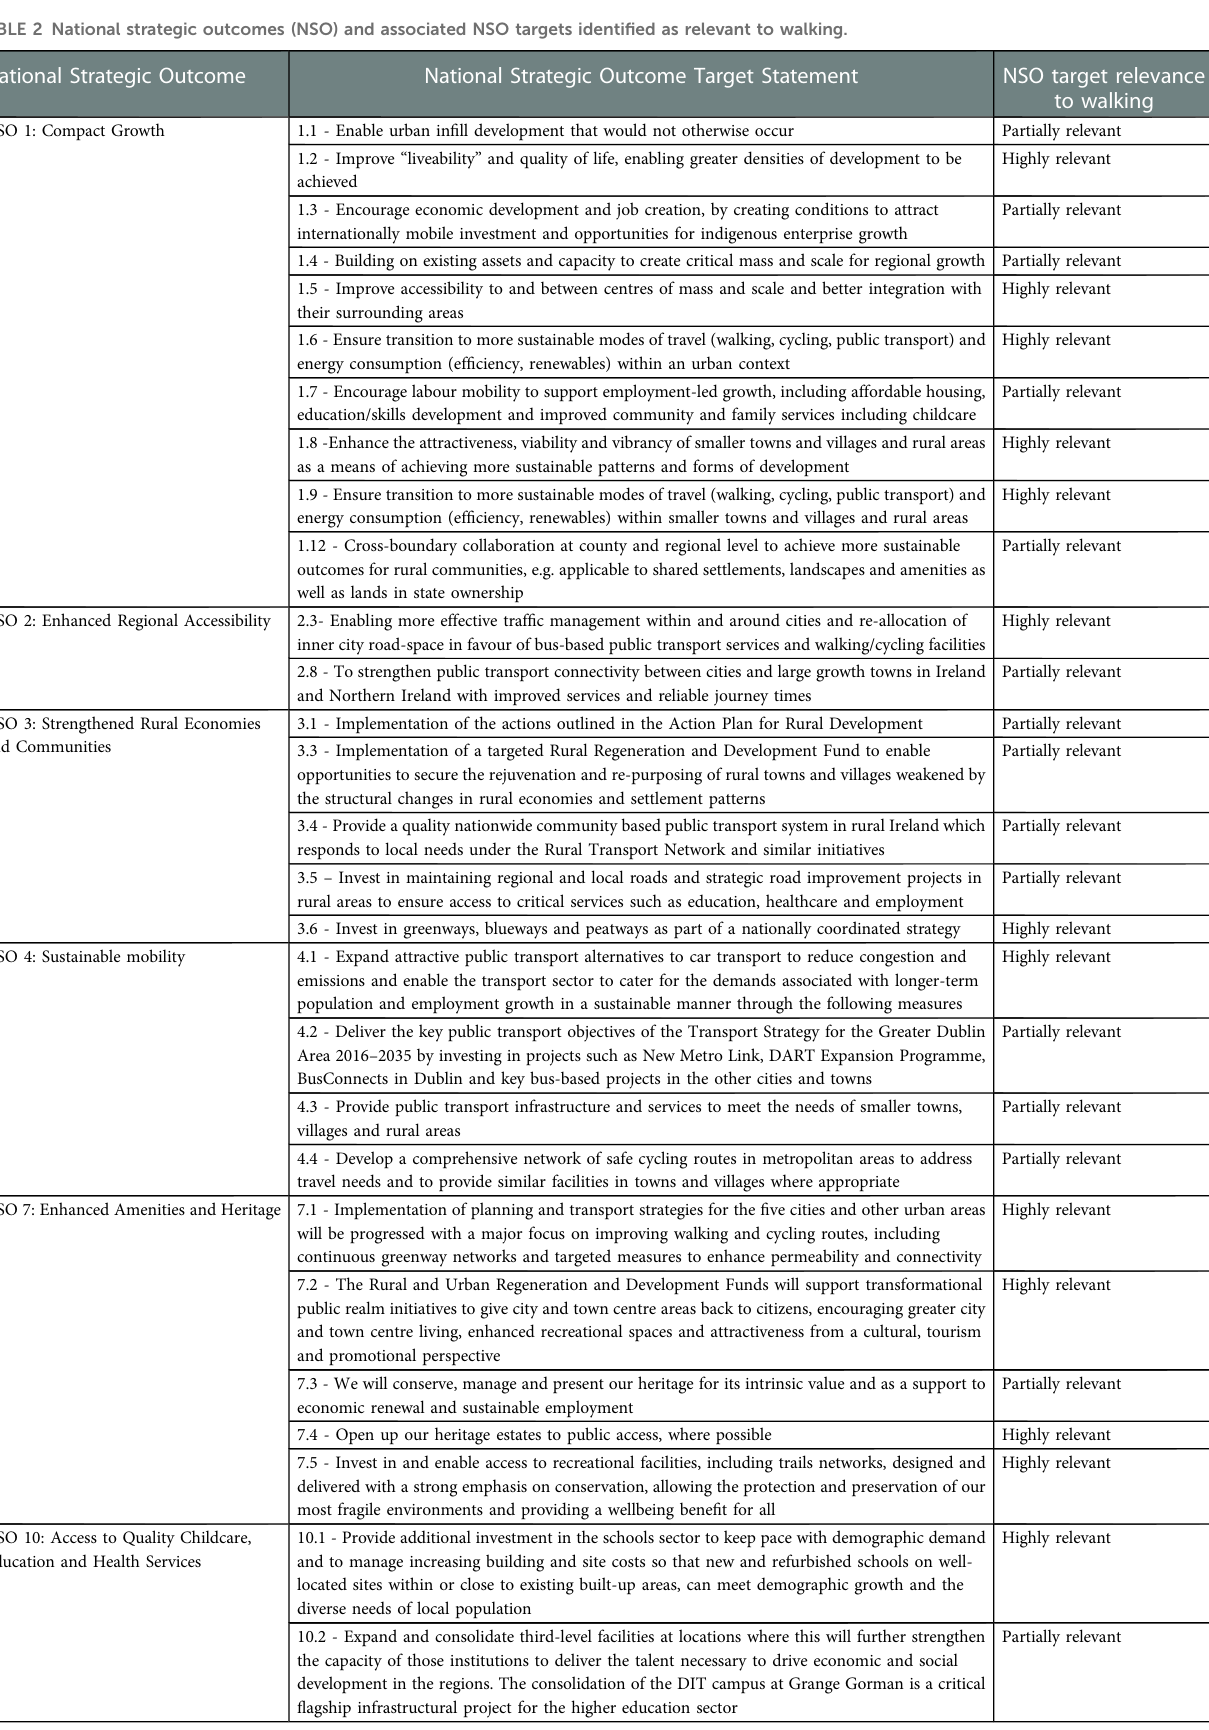
TABLE 2 National strategic outcomes (NSO) and associated NSO targets identi fi ed as relevant to